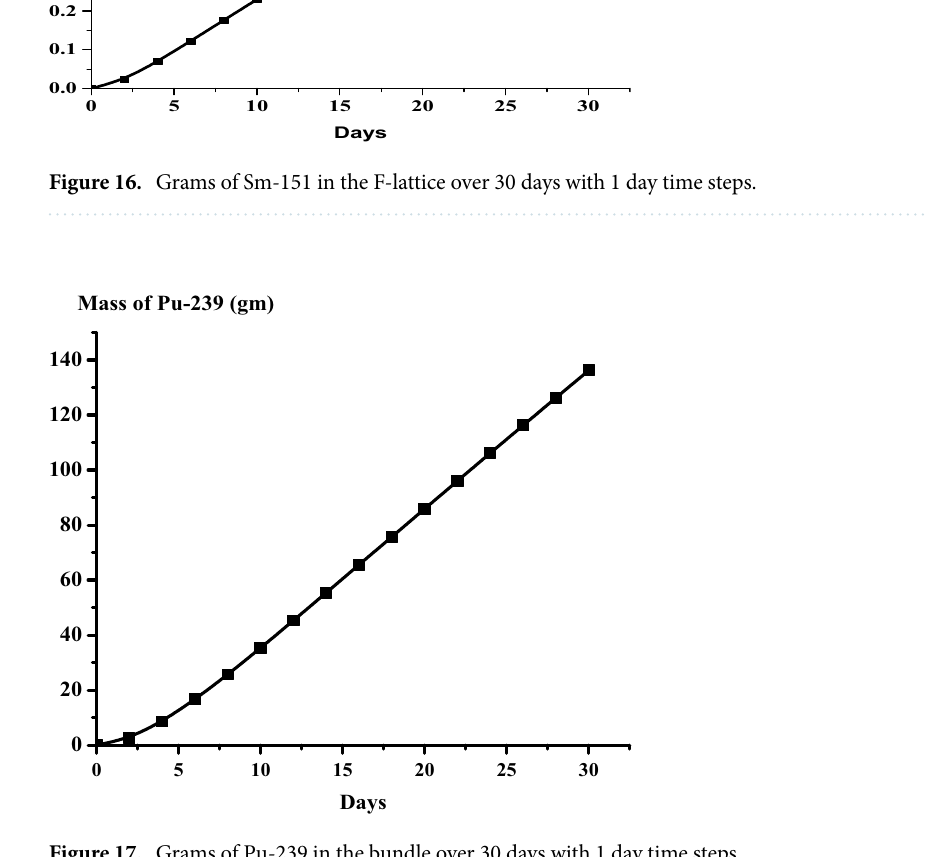
Figure 17. Grams of Pu-239 in the bundle over 30 days with 1 day time steps.